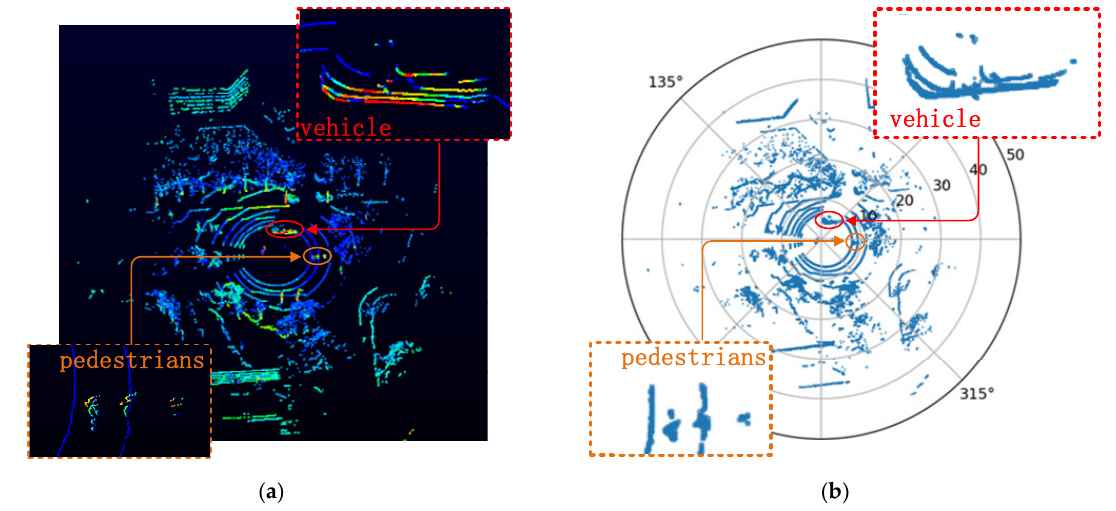
Figure 8. The point cloud display in different coordinates. ( a ) The original point cloud displayed in the VeloView software. ( b ) The result of the projecting point cloud.